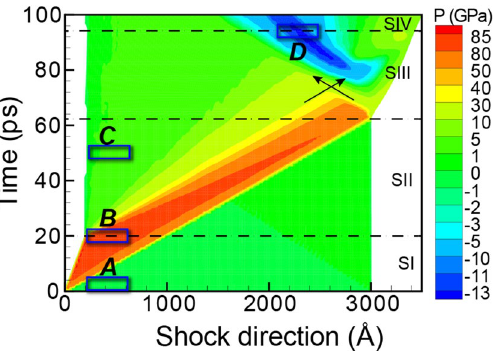
Figure 1. The temporal evolution of pressure for shocked Ta. The stages of shock are separated by dashed lines, and the region of triaxial tension is indicated by black arrows. Blue rectangles, labeled A–D, mark the regions examined in Fig. 2 and Table